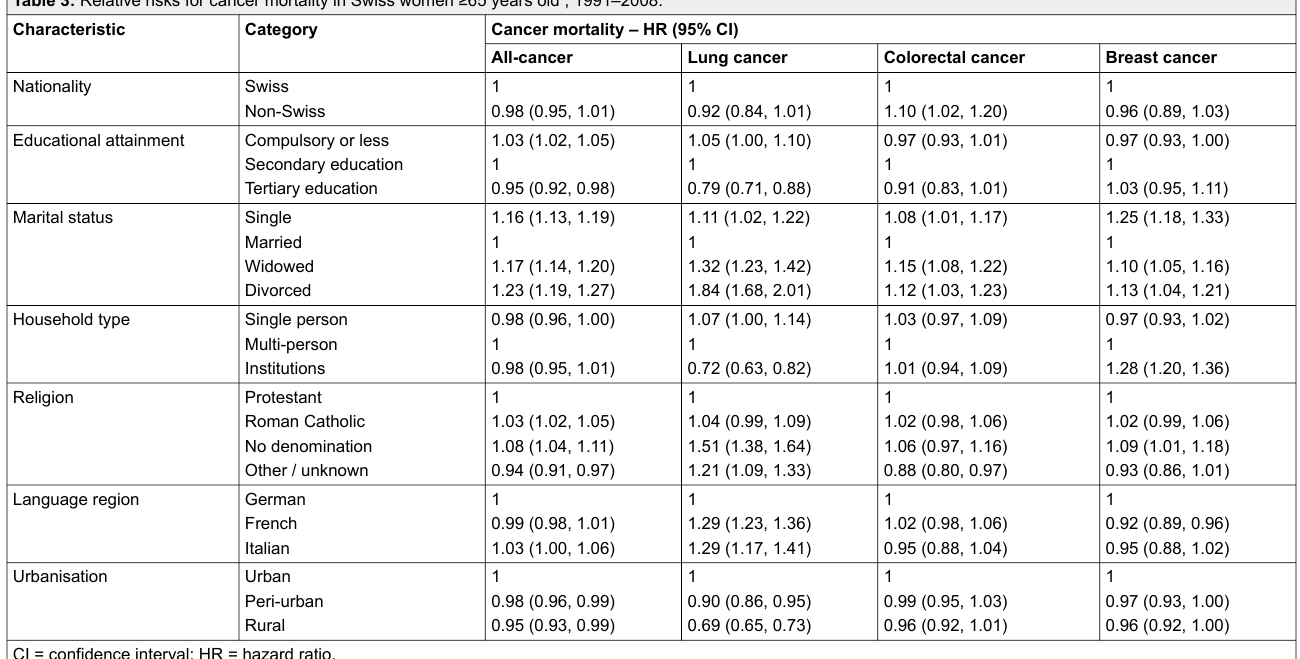
Table 3: Relative risks for cancer mortality in Swiss women ≥65 years old , 1991–2008.